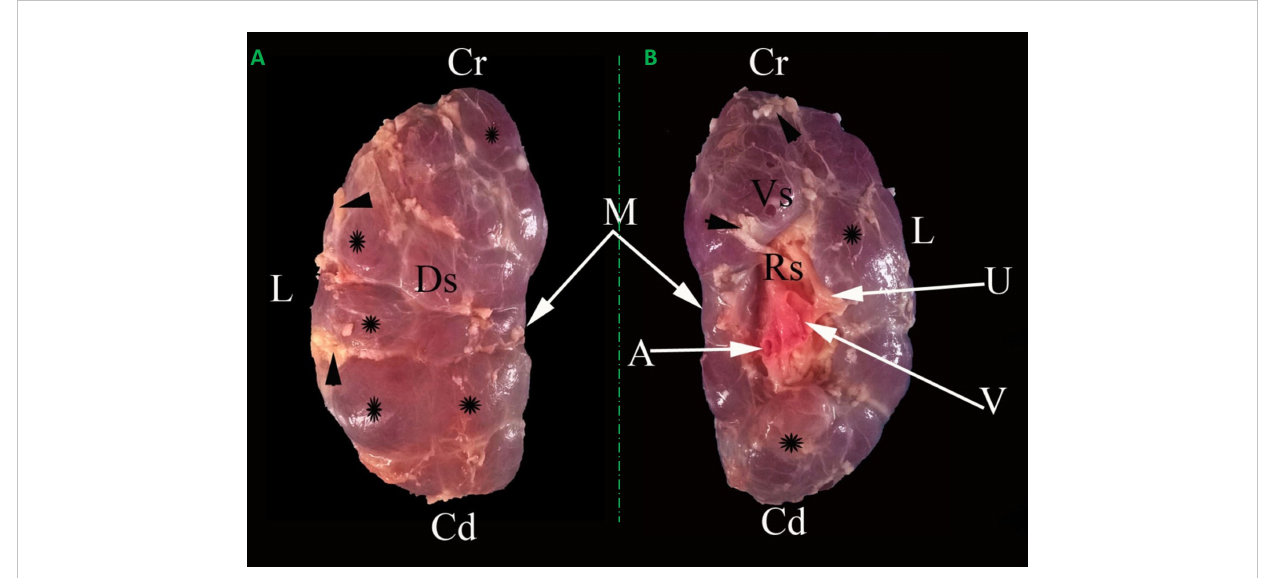
FIGURE 2 Representative dorsal (A) and ventral (B) macroscopical views of the encapsulated right kidney of oxen. Cr: Cranial pole; Cd: caudal pole; Ds: dorsal surface; Vs: ventral surface; M: medial border; L: lateral border; A: renal artery; V: renal vein; U: ureter; Rs: renal sinus; renal lobules (*); interlobar fi ssures fi lled with adipose tissue